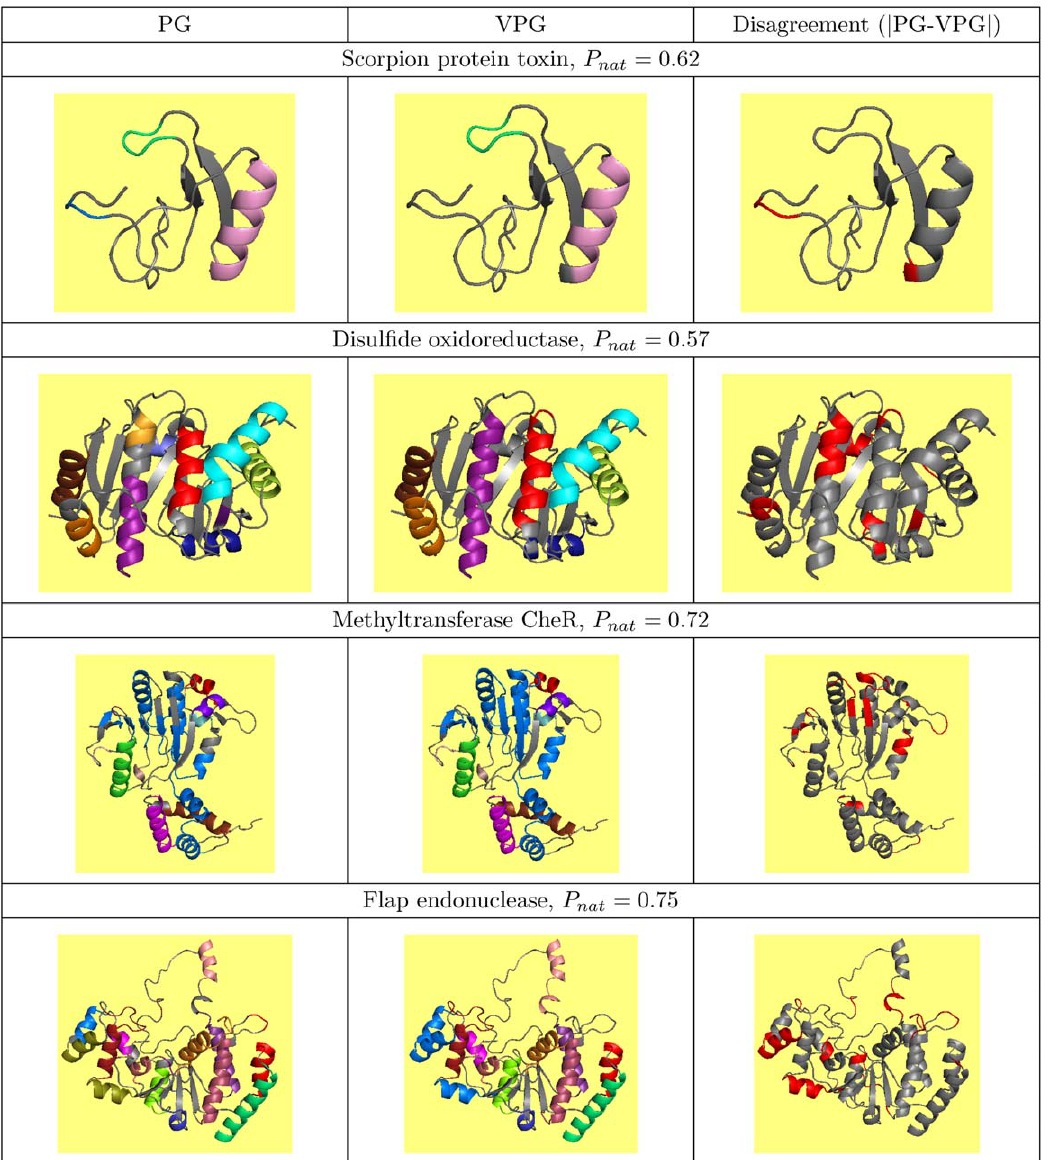
Figure 4. Rigid Cluster visualizations for four example proteins. The first column highlights the rigid clusters identified within the PG realization that corresponds to the median RM value, designated PG med . The middle column corresponds to the rigid clusters identified by the VPG. Finally, differences between the two algorithms are highlighted in the third column.